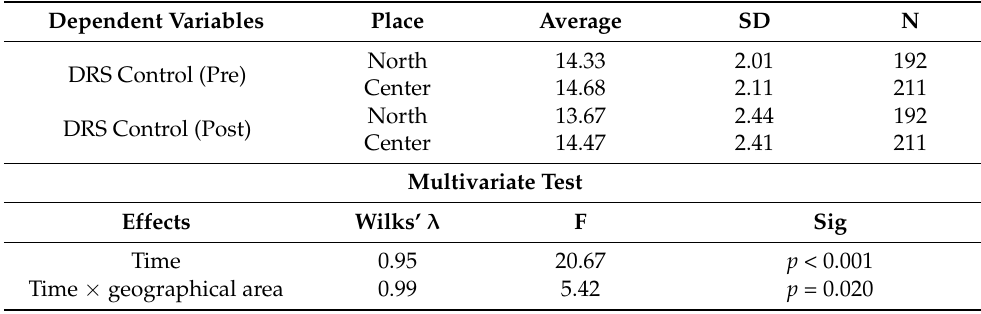
Table 16. Repeated measures ANOVA model of time (i.e., pre- and post-pandemic first-wave effect) and geographical area effects on control hardiness.